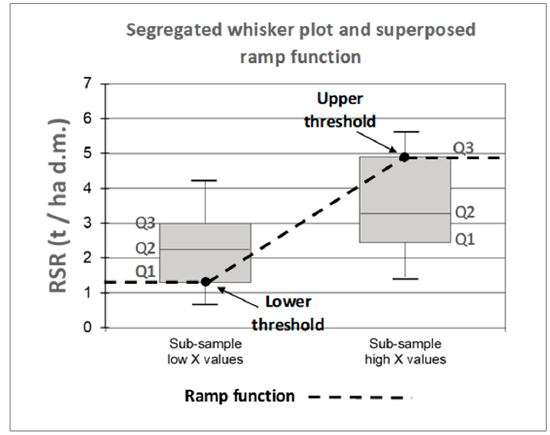
Figure 2. Ramp function building from values of segregated whisker plots .